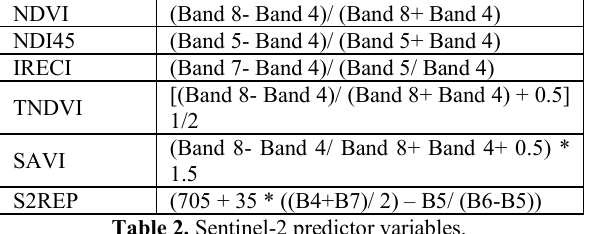
Table 2. Sentinel-2 predictor variables.